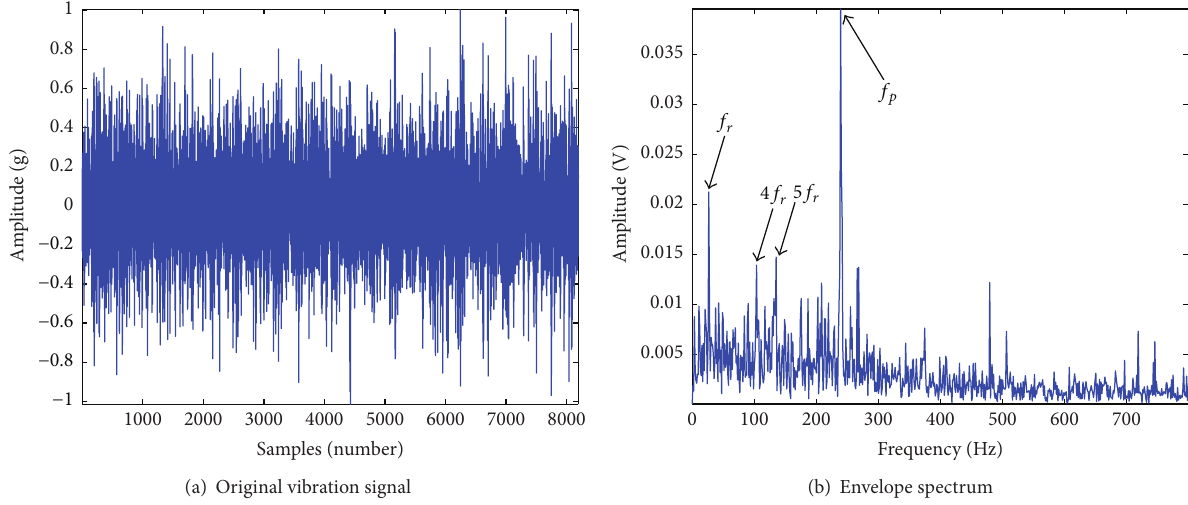
Figure 4: Original signal and envelope spectrum of bearing with compound